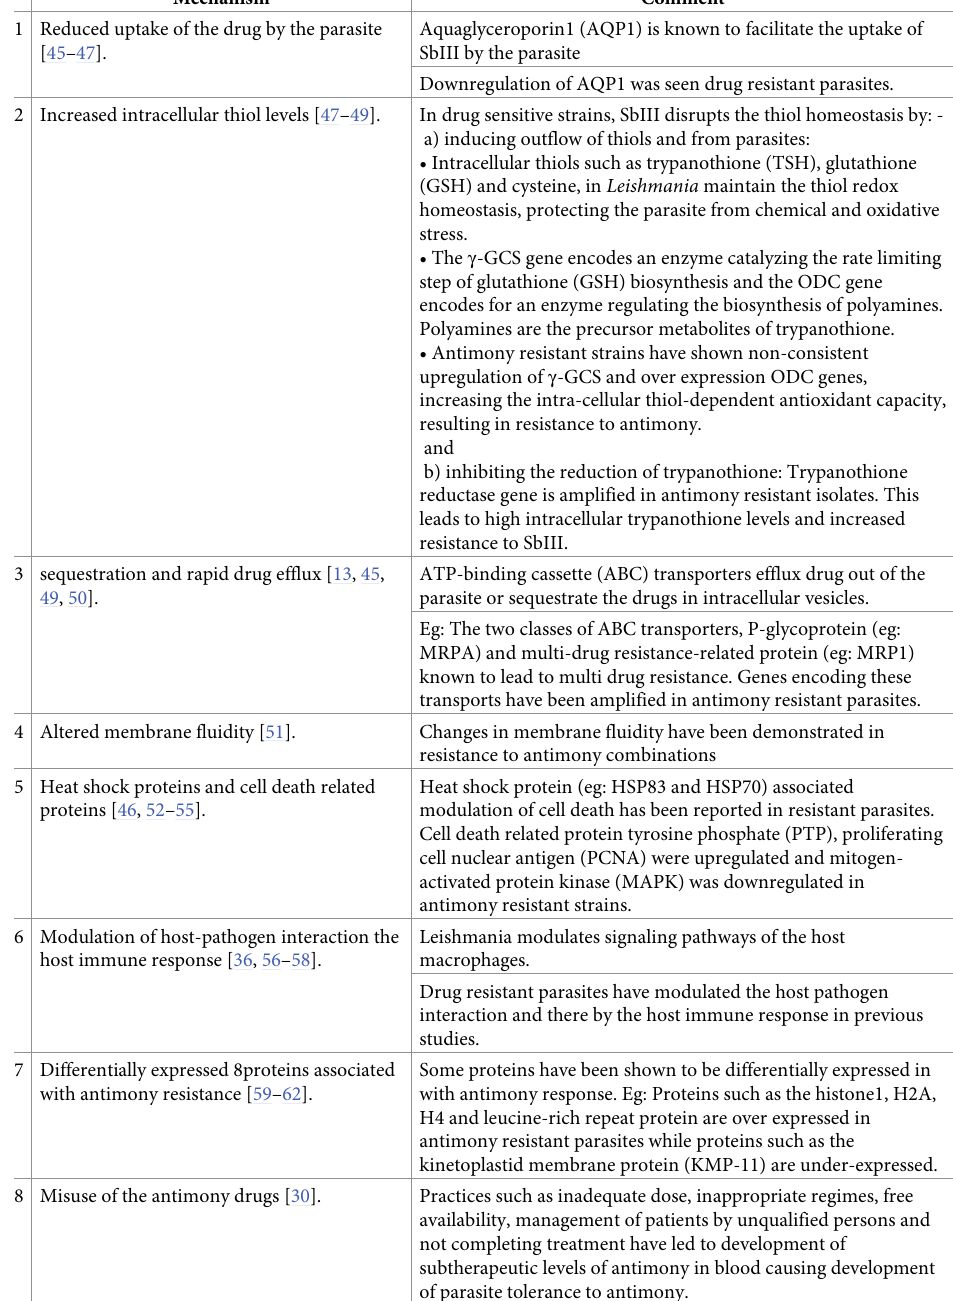
Table 5. Mechanisms of the antimony